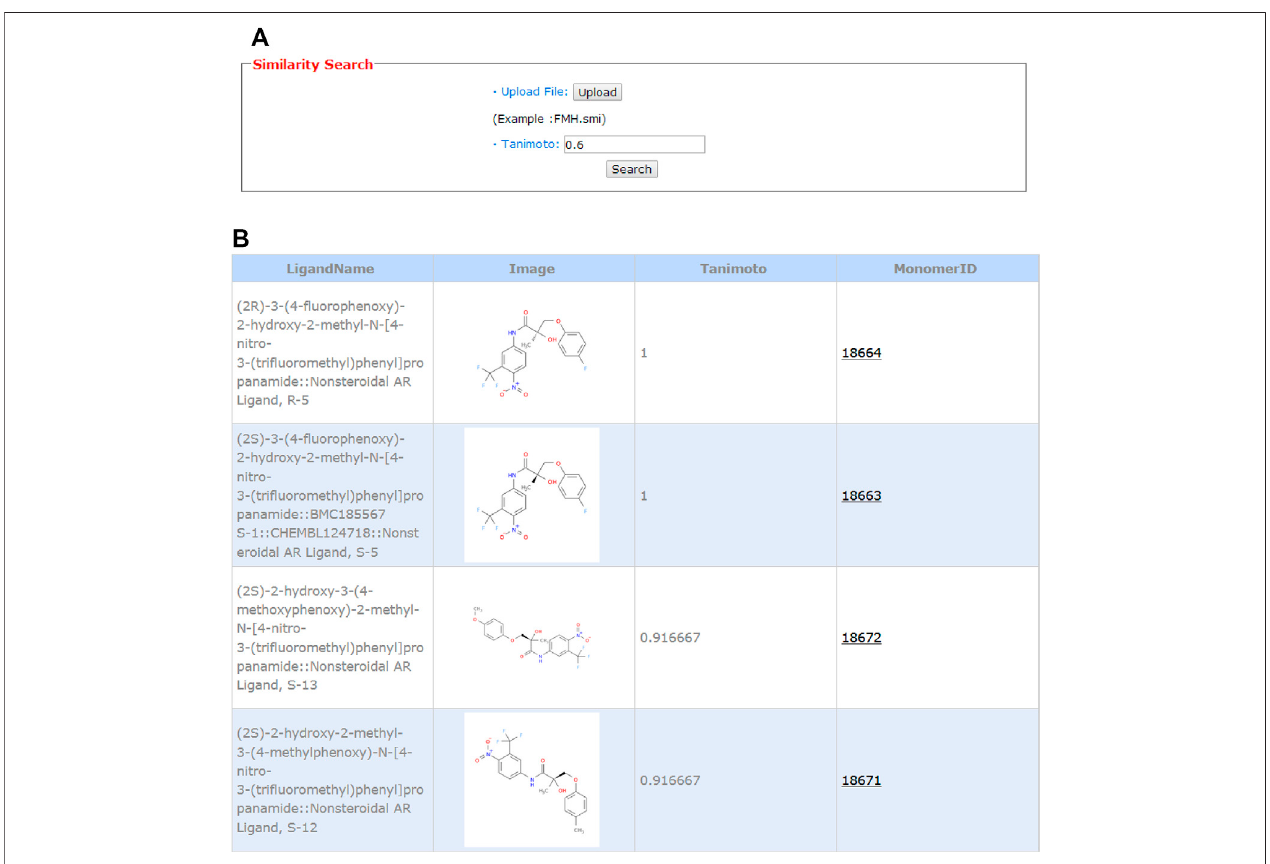
FIGURE 5 | Input (A) and output (B) webpages for 2D similarity